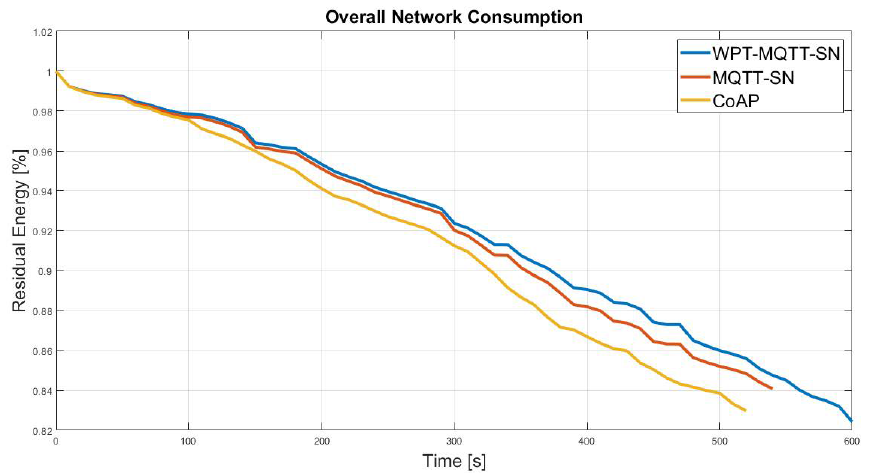
Figure 15. Normalised average residual battery level achieved by the CoAP, MQTT-SN and MQTT- SN-WPT protocols in a Unbalanced Random Mesh topology nodes deployment.